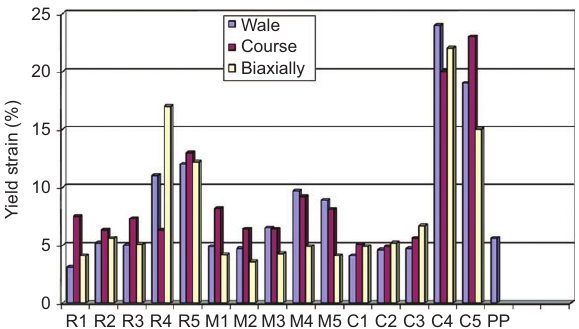
Figure 8 Results of composite ’ s break